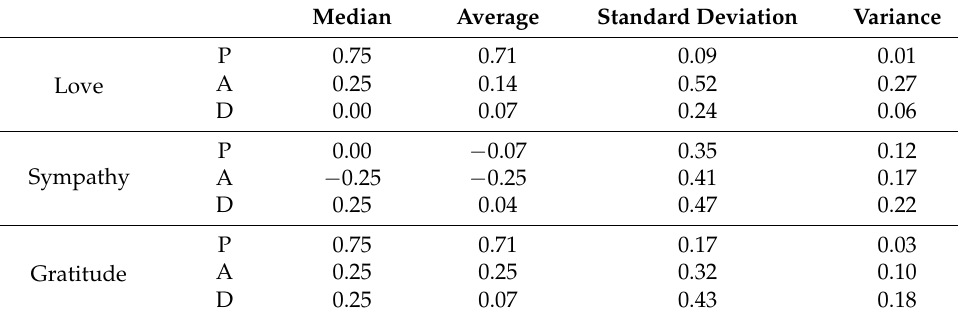
Table 4. PAD of emotion that participants evaluate after